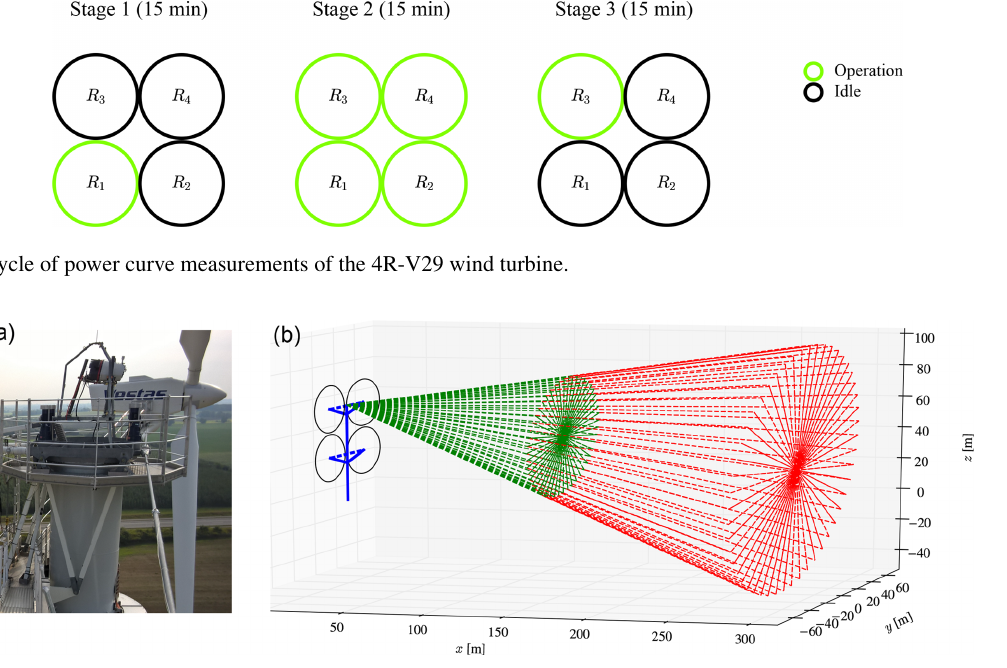
Figure 3. (a) The ZephIR Z300 placement on the 4R-V29 wind turbine. (b) Scanning cone for x = 146m (green) and x = 300m (red).